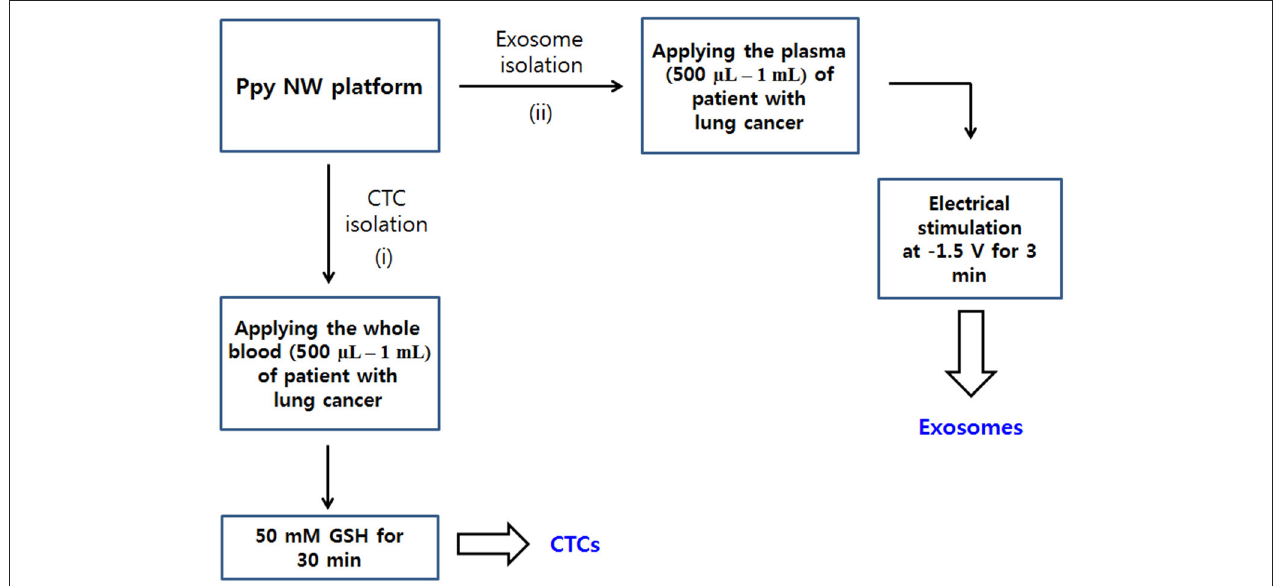
FIGURE 2 | Workflow for isolating CTCs (i) and exosomes (ii) from body fluid samples of cancer patients. Ppy NWs conjugated with simultaneously exosome-specific antibodies and CTC-targeting antibodies allow for continuous extraction of exosomes and CTCs from a single platform by applying electrical stimulation (ES) and GSH